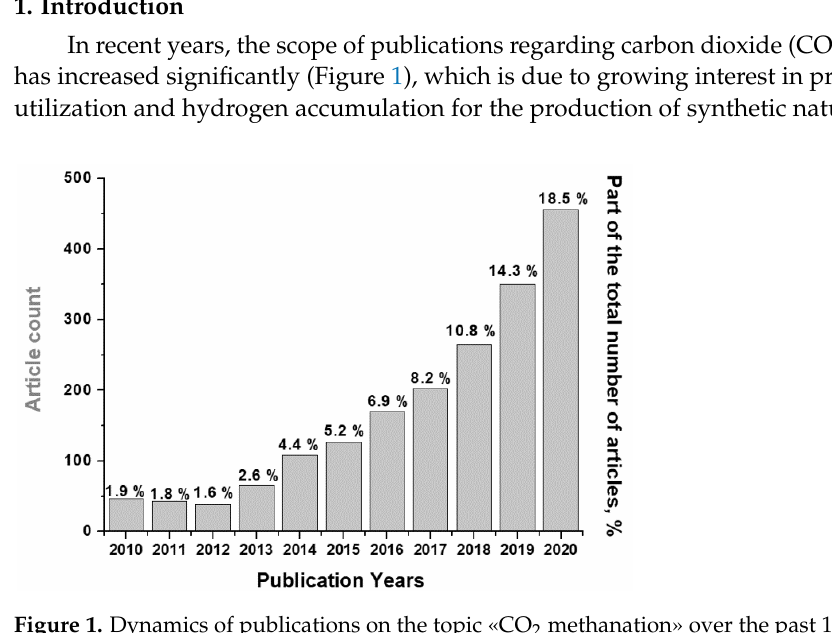
Figure 1. Dynamics of publications on the topic «CO 2 methanation» over the past 11 years (“Web of Science” database).